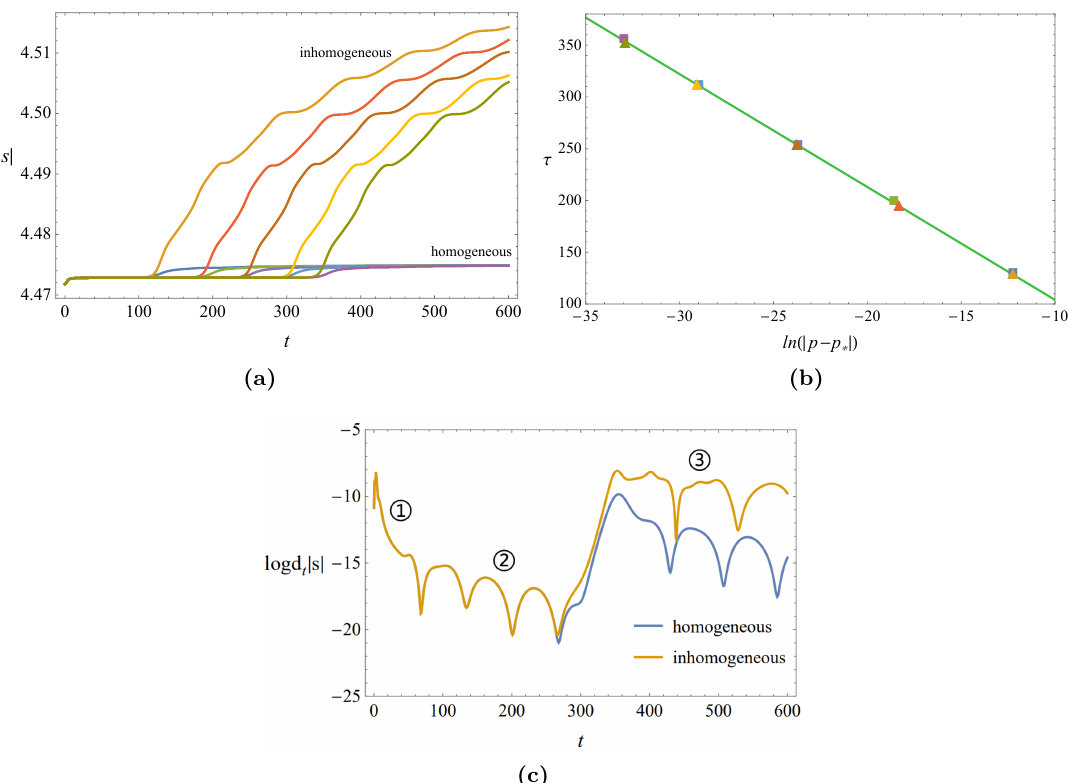
Figure 4. (a): the evolution of the average entropy for various p close to the threshold p ∗ ≈ 0 . 929654988651265 . The time-dependent entropy density is defined as s = 2 π Σ 2 Σ H represents the value of the metric field Σ at the apparent horizon. The average entropy of the system is defined as | s | = R sdx/ ( L x π ) . The curves in different colors represent the corresponding dots in (b). Specifically, the triangle and square dots in (b) correspond to the inhomogeneous and homogeneous final states respectively. (b): the duration of the system near a critical solution with respect to ln | p − p ∗ | . Note that the calculation of the time τ actually includes the first stage for convenience. It does not affect the critical exponent since the time for the first stage is the same